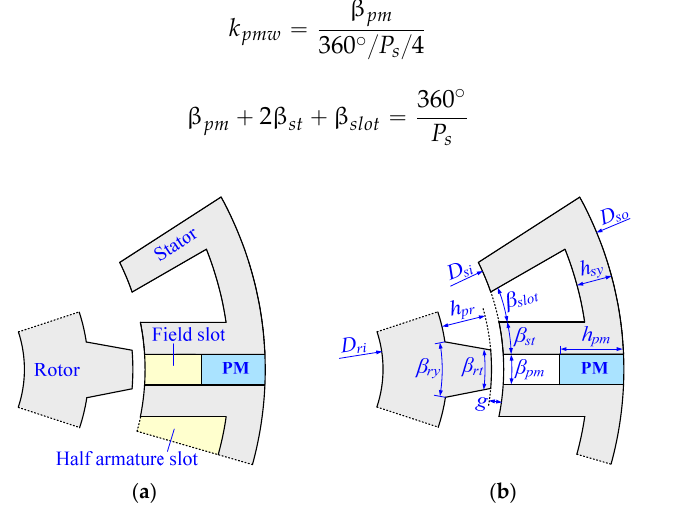
Figure 3. Configuration and design dimensions of PM-top HEFS machine. ( a ) Configuration; ( b ) Design dimensions.